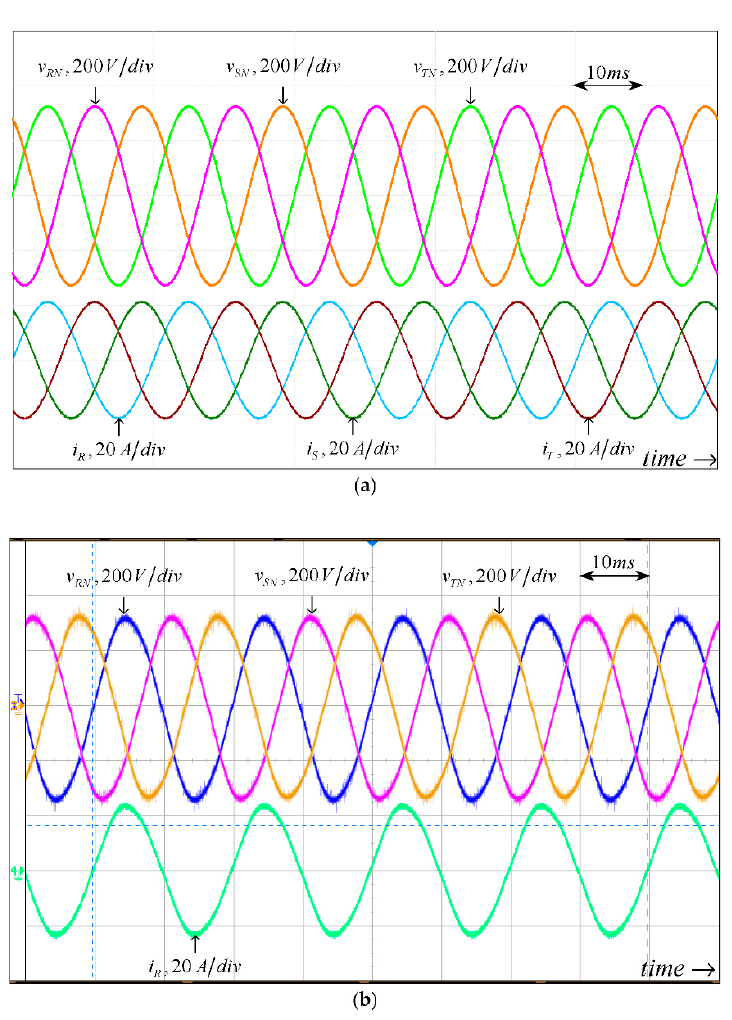
Figure 6. AC-side nominal loaded converter voltages and currents. ( a ) Simulation. ( b ) Experiment.